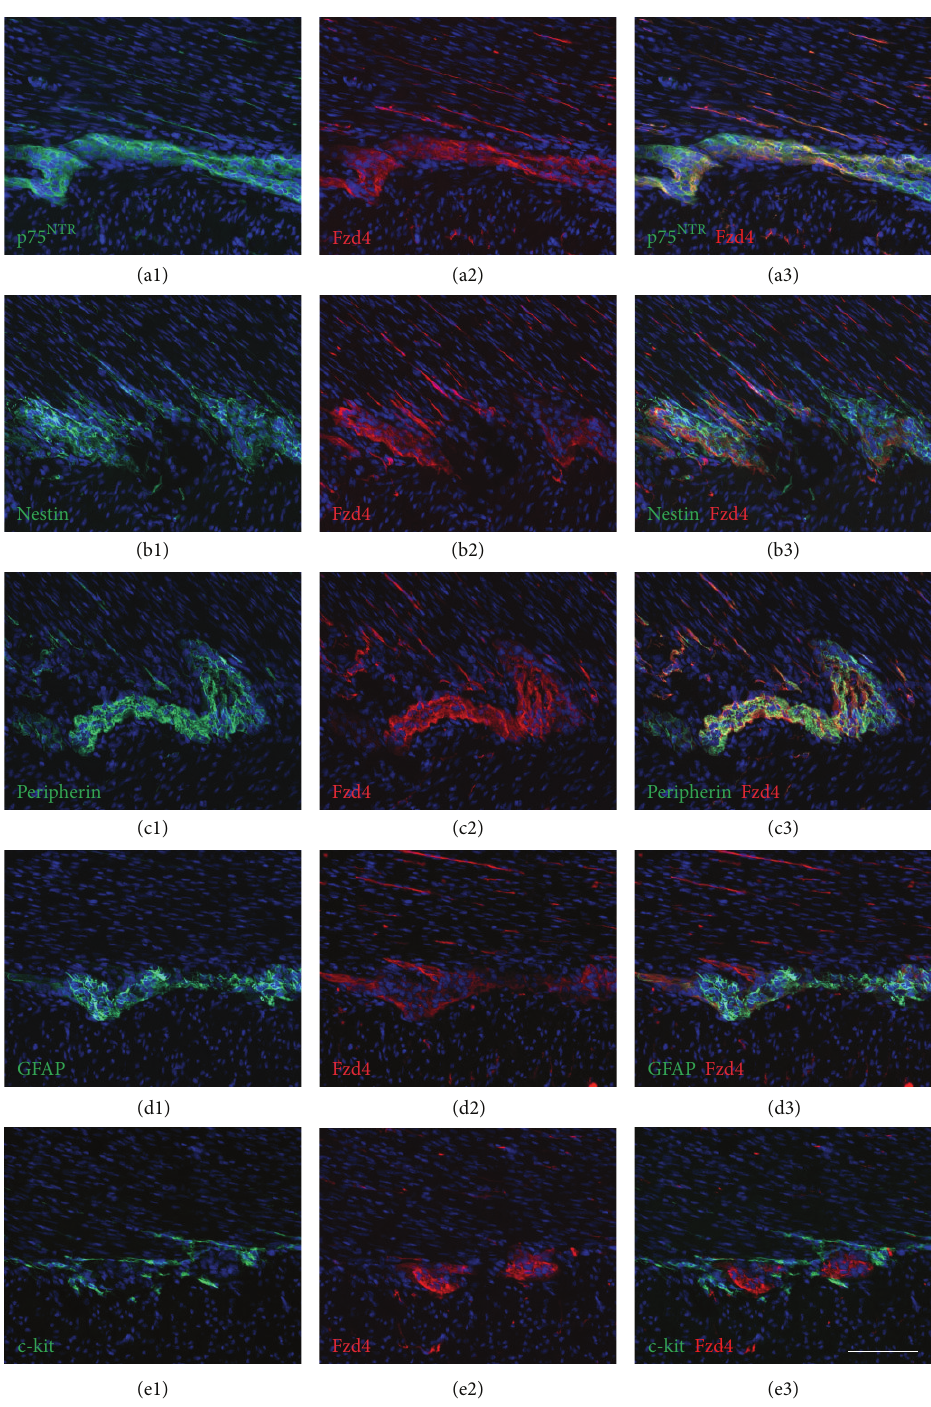
Figure 2: Frizzled-4 is detected in a subpopulation of neural cells. Immunofluorescence for frizzled-4 (Fzd4), p 75 NTR , nestin, peripherin, GFAP, and c-kit on cryostat sections of human ileum (sample number 2). ((a1)–(a3)) Combined p 75 NTR (green) and Fzd4 (red) immunostaining of myenteric ganglia; p 75 NTR (a1); Fzd4 (a2); merge (a3); DAPI (blue). ((b1)–(b3)) Combined nestin (green) and Fzd4 (red) immunostaining of myenteric ganglia; nestin (b1); Fzd4 (b2); merge (b3); DAPI (blue). ((c1)–(c3)) Combined peripherin (green) and Fzd4 (red) immunostaining of myenteric ganglia; peripherin (c1); Fzd4 (c2); merge (c3); DAPI (blue). (d1–d3) Combined GFAP (green) and Fzd4 (red) immunostaining of myenteric ganglia; GFAP (d1); Fzd4 (d2); merge (d3); DAPI (blue). ((e1)–(e3)) Combined c-kit (green) and Fzd4 (red) immunostaining of myenteric ganglia; c-kit (e1); Fzd4 (e2); merge (e3); DAPI (blue); scale bar (a–e): 100 𝜇